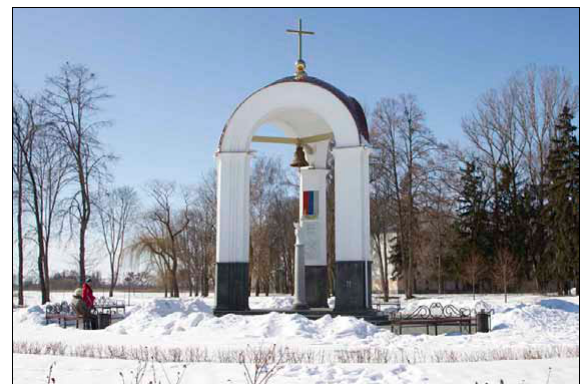
fig. 8. Poltava, Poltava Battlefield. Belfry-chapel, 2009. General view. Source : http://www.charity-ukraine.privat-online. net/polt_bat.html.